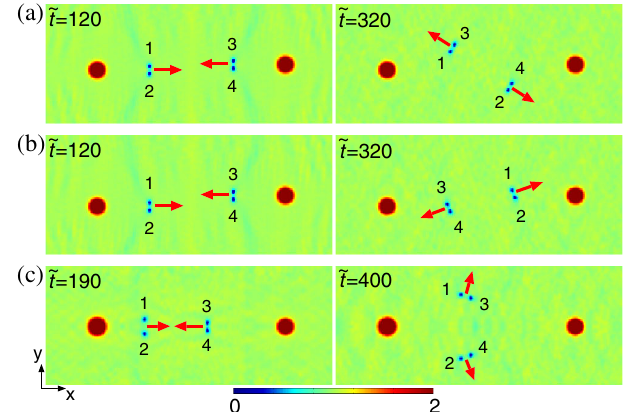
FIG. 10. Collisions between vortex dipoles launched by the method in Fig. 3. The directions in which the vortex dipoles propagate are indicated by the arrows. The numbers identify the vortices. (a) Collision with the impact parameter (cid:15)=(cid:2) ¼ 3 : 16 . Vortex exchange occurs. (b) Collision with (cid:15)=(cid:2) ¼ 6 : 32 . The two vortex dipoles pass each other. (c) Collision of vortex dipoles with different velocities. The beam waist is d=(cid:2) ¼ 3 : 54 for the left-hand side in (c) and d=(cid:2) ¼ 3 : 16 for the others. The other parameters are the same as those in Fig. 3. The field of view of each panel is 78 (cid:2) (cid:5) 33 (cid:2) . (See also Supplemental Material